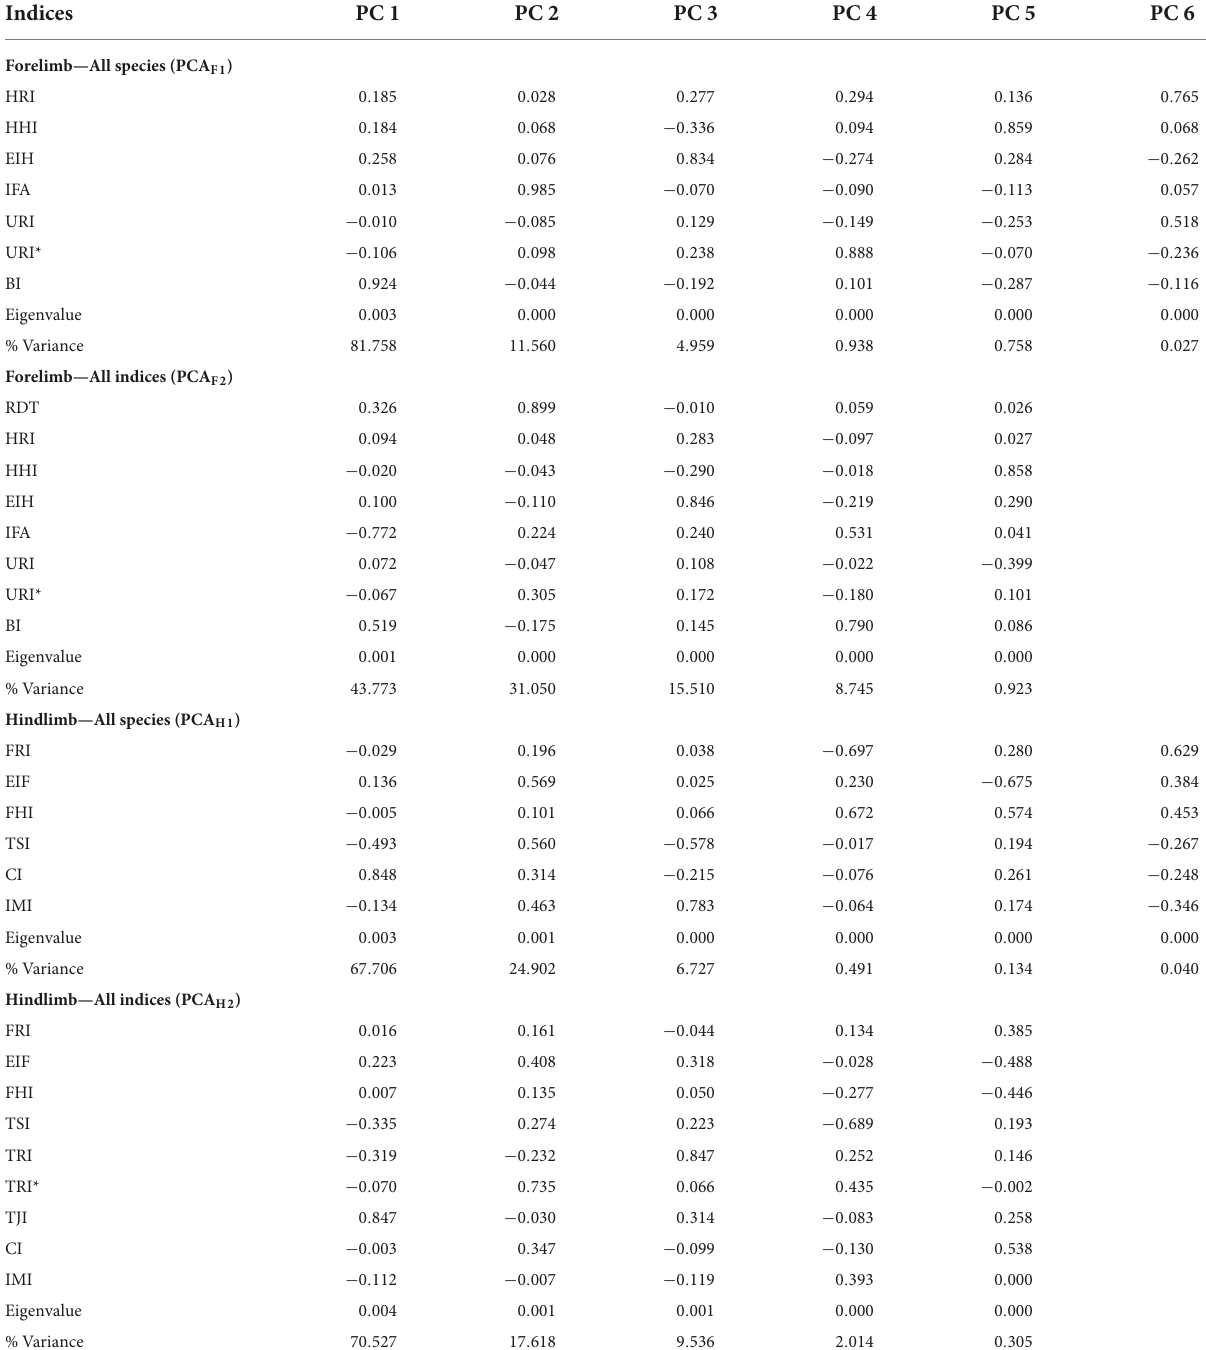
TABLE 5 Coefficients, eigenvalues, and proportion of variance for each principal component (PC) obtained for the analysis of forelimbs and hindlimbs, including all species (PCA F1 and PCA H1 ) and all indices (PCA F2 and PCA H2 ).